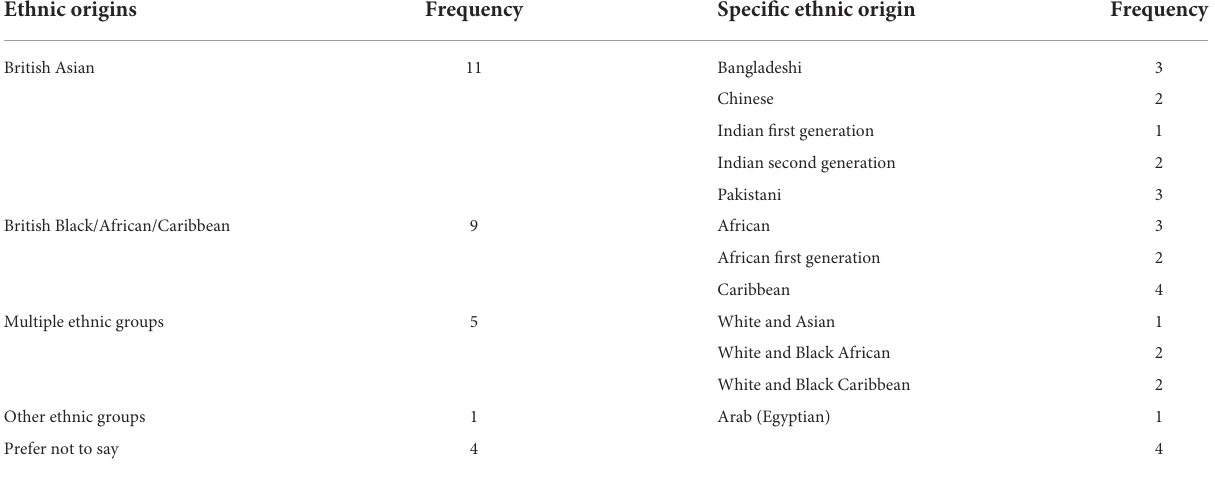
TABLE 1 Demographic information on ethnic origins ( n = 30).